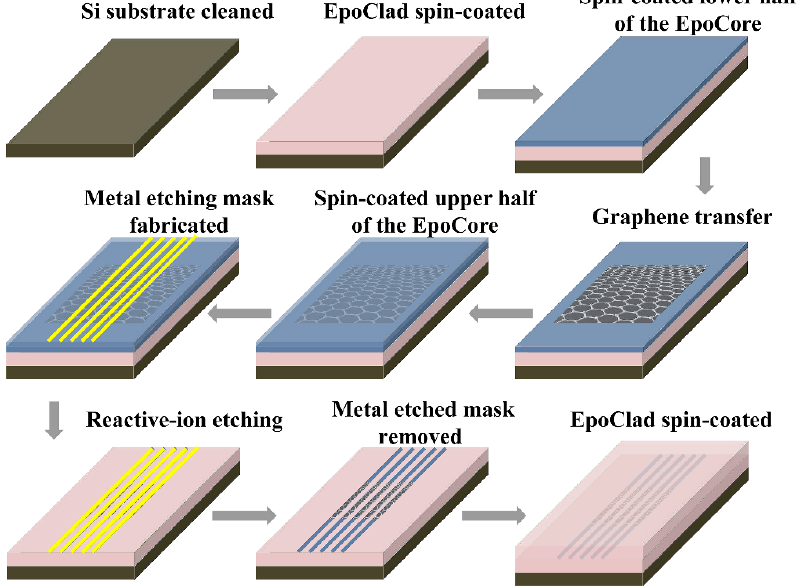
Figure 4. The fabrication process of the polarizer with graphene film buried in the center of core layer.